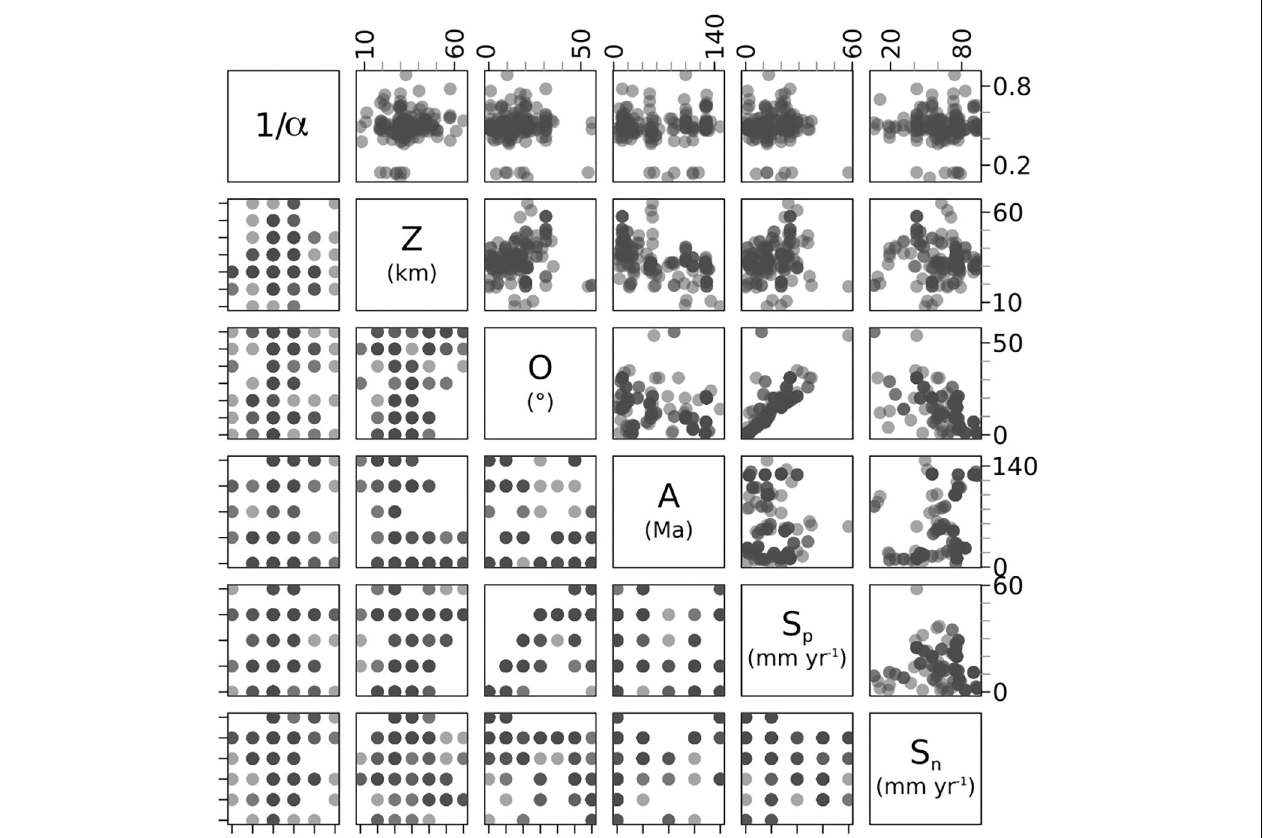
FIGURE 3 | Pairs plot of all variables for the 162 volcanoes used in this study. Darker regions in each graph represent a higher density of volcanoes. The upper right panel contains the continuous data, with the relevant units labeled in the diagonal. The bottom left quadrant is the discretized data. The bounds of each interval are chosen to distinguish clusters of data in each parameter and can be found in the Supplementary Figure 1 . Consequently, the bottom left panel is broadly a mirror image of the upper right panel. This can be observed by comparing the relationship between convergence obliquity (O) and the parallel component of subduction (Sp). Note we present the inverse of α , so larger values represent increased probability of recording larger eruptions. Descriptions of each parameter can be found in Table 1 .